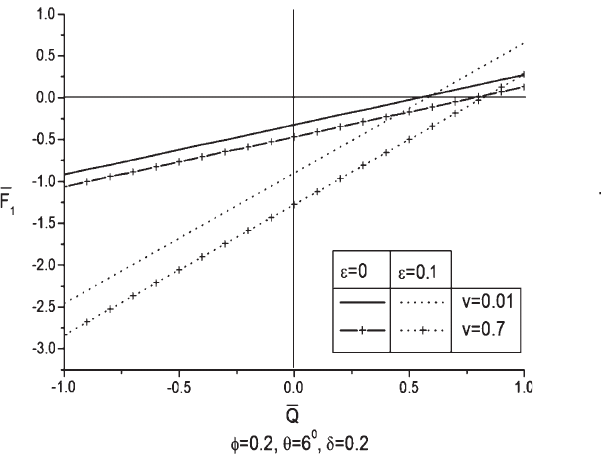
Fig. 8. Variation of the average inner Friction force versus Q with different values of (cid:2) and v .